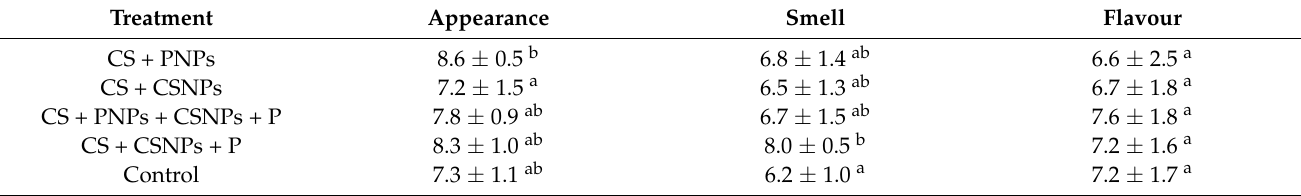
Figure 4. Effect of edible of chitosan/propolis on the aflatoxins production of A. flavus in fig fruit stored for 15 days at 4 °C. Means with similar letters are not significantly different among the evaluated treatments. CS (chitosan), P (propolis extract), CSNPs (chitosan nanoparticles), PNPs (propolis nanoparticles). ANOVA and Tukey test ( p ≤ 0.05) were